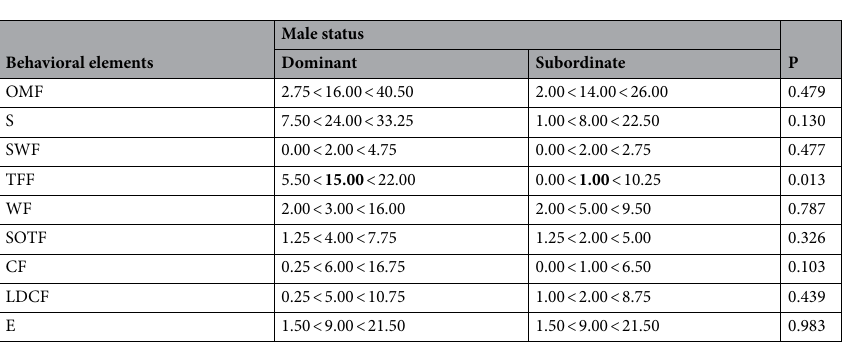
Table 4. Frequencies of courtship behavioral elements of Anastrepha curvicauda dominant and subordinate (7–8 days old) males caged with a virgin 5–7 days old female. Choice experiment. Reported values are Q1 < Median < Q3 (n = 15). Medians in bold in the same row are significantly different (Mann–Whitney test, p > 0.05). See Table 1 for